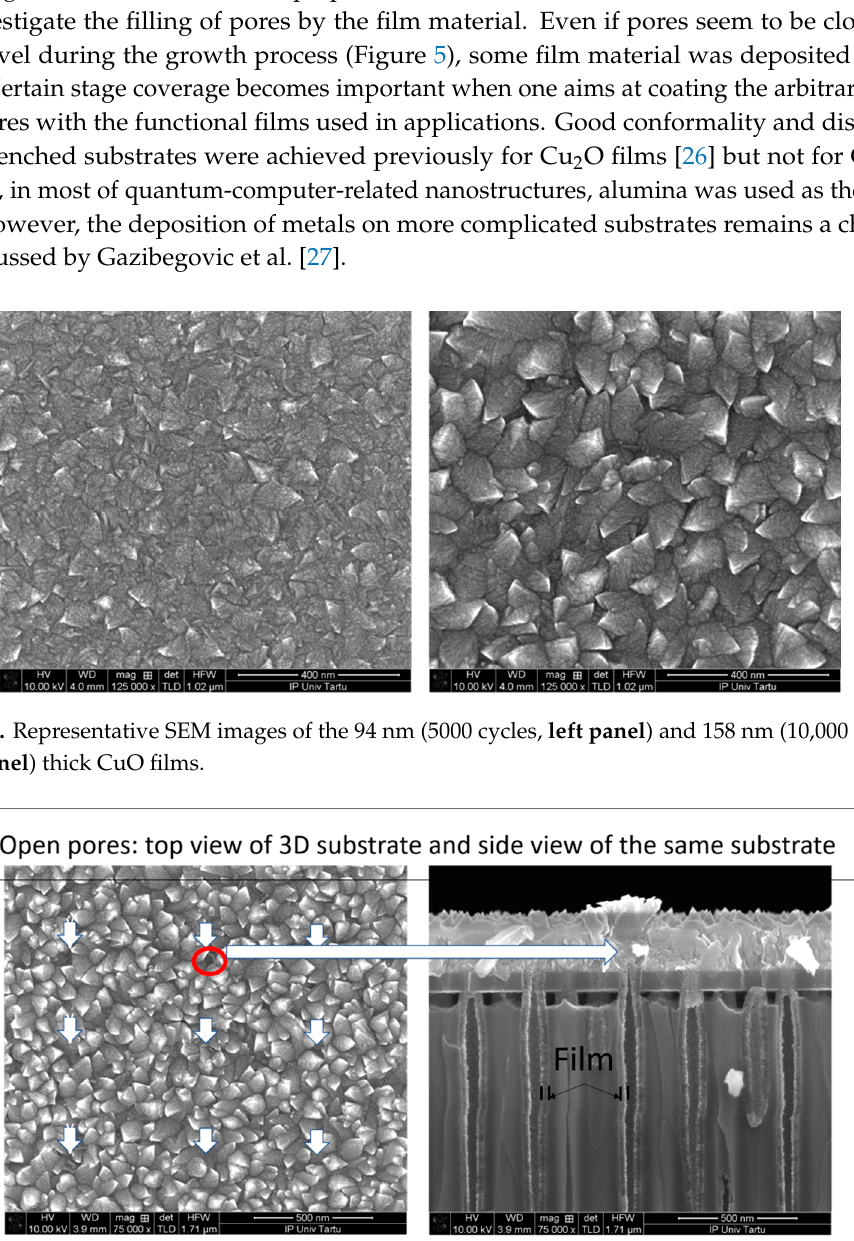
Figure 5. Representative SEM images of 3D structures, called stacks, in the left panel , top view of the stack; in the right panel , the CuO film inside 3D substrate (stack) are shown.